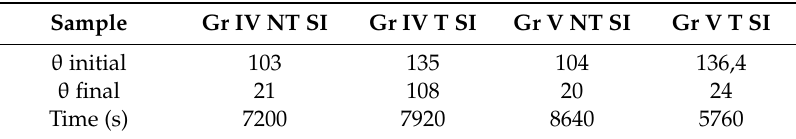
Table 12. Absorbance and number of cells arising from the result on the samples studied in cell culture.